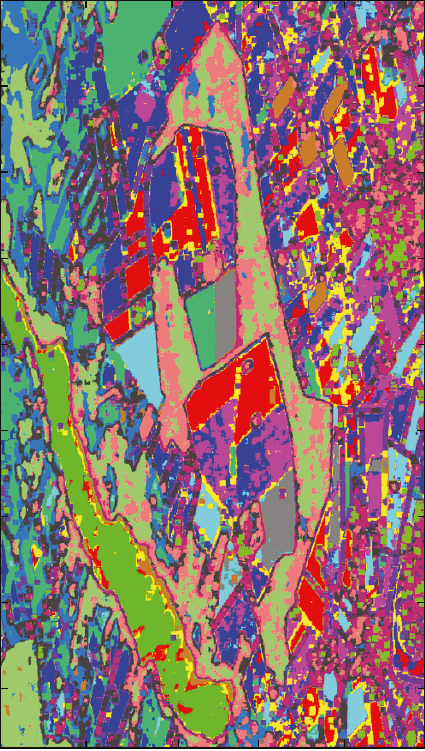
Figure 12: Polarimetry ( Γ matrix) image shown as Pauli RGB colours ( R = | HH − VV | , G = | HV | , B = | HH + VV | ).